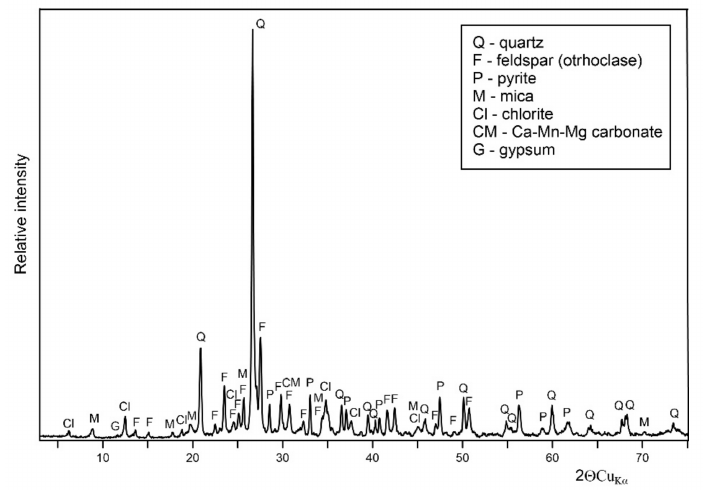
Figure 2. X-ray di ff raction pattern of the long-term stored waste